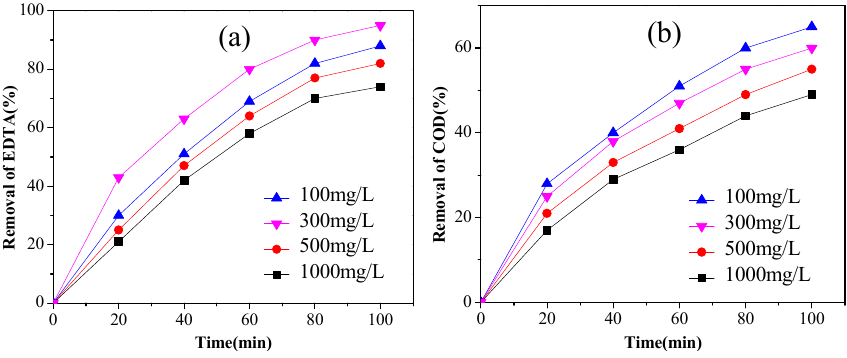
Figure 4. The effect of initial EDTA concentration on EDTA removal ( a ) concentration; ( b ) COD (3% Pt/ACF electrode; current density: 40 mA/cm 2 ; electrolyte concentration: 0.1 mol/L).